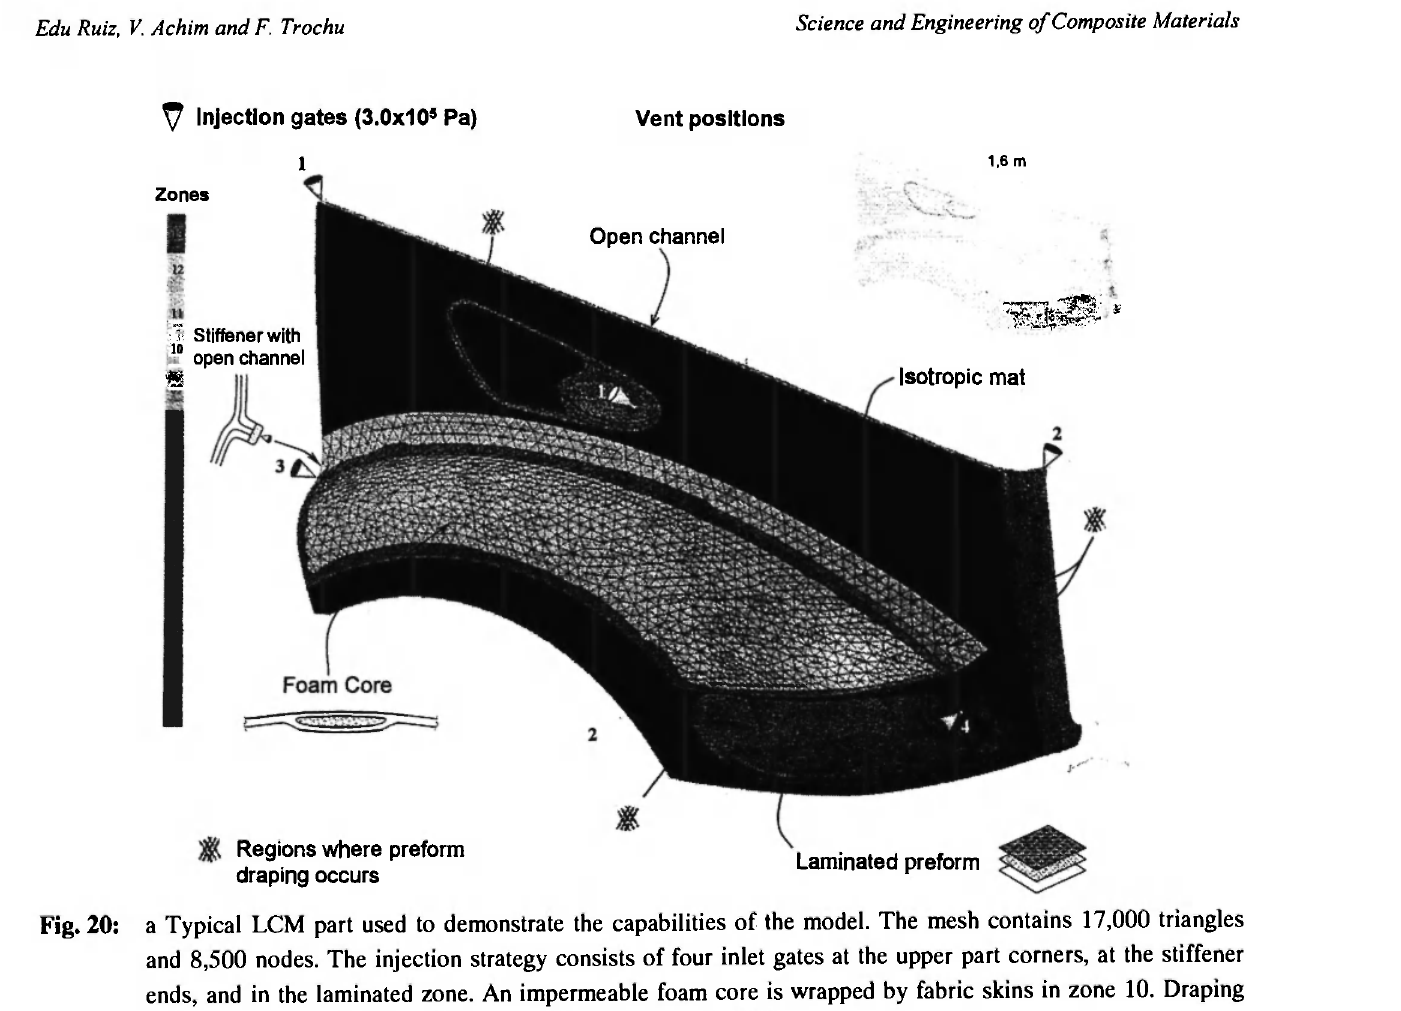
a Typical L CM part used to demonstrate the capabilities of the model. The mesh contains 17,000 triangles and 8,500 nodes. The injection strategy consists of four inlet gates at the upper part corners, at the stiffener ends, and in the laminated zone. An impermeable foam core is wrapped by fabric skins in zone 10. Draping effects are represented as regions with high or low permeabilities.